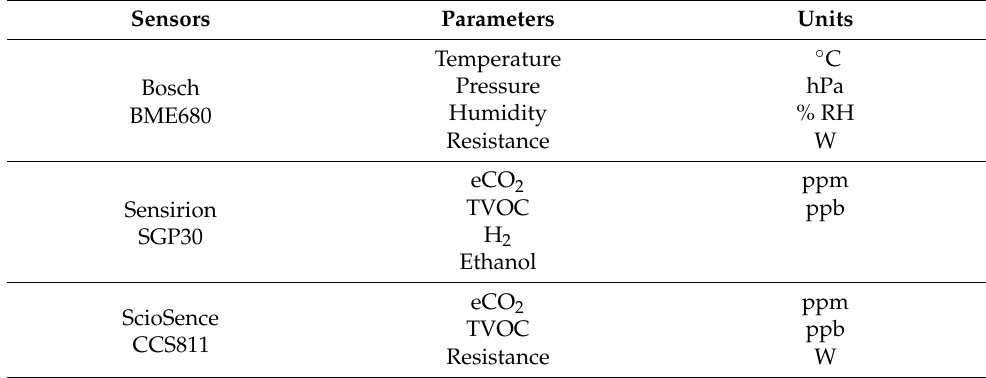
Table 1. Sensors used in the